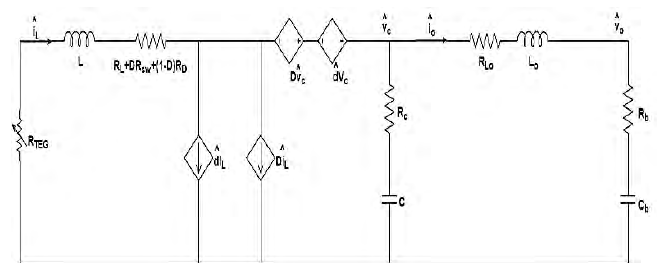
Figure 7. Small signal model of the